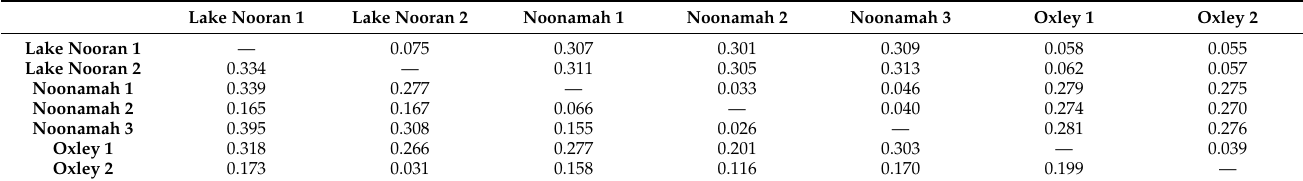
Table 5. F ST values for each patch for M. drummondii on the bottom left and E. acuta , on the top right of the